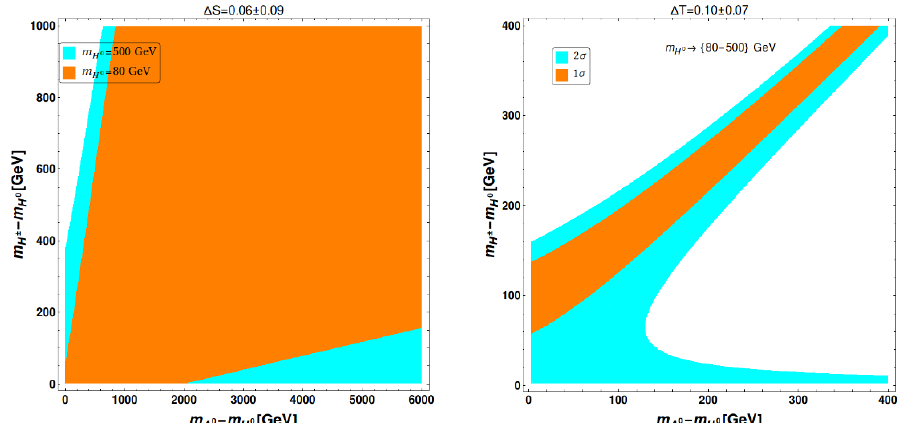
(cid:0) m and m (cid:0) m plane. For A 0 H 0 H 0 H (cid:6) = f 80 ; 500 g GeV. For (cid:1) T scan, we H 0 = f 80 (cid:0) 500 g GeV. H 0